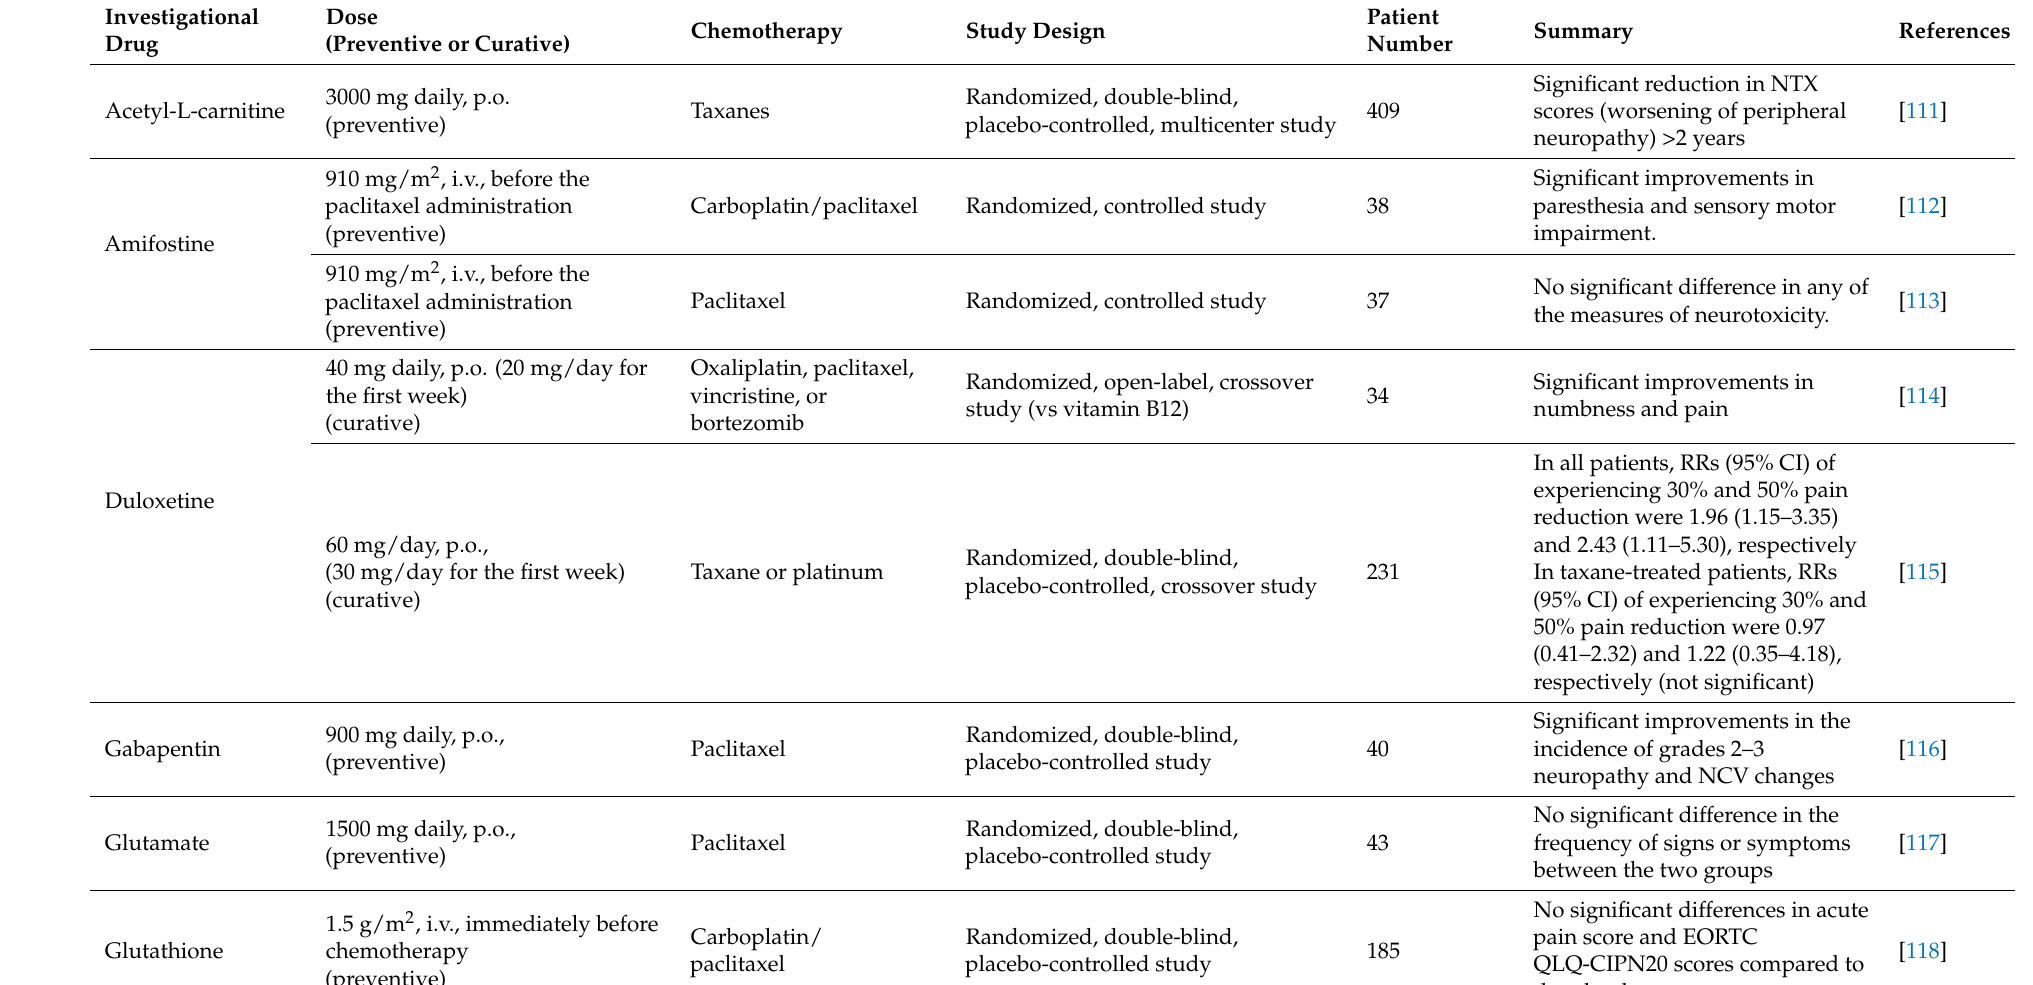
Table 2. The therapeutic drugs for paclitaxel-induced peripheral neuropathy in clinical